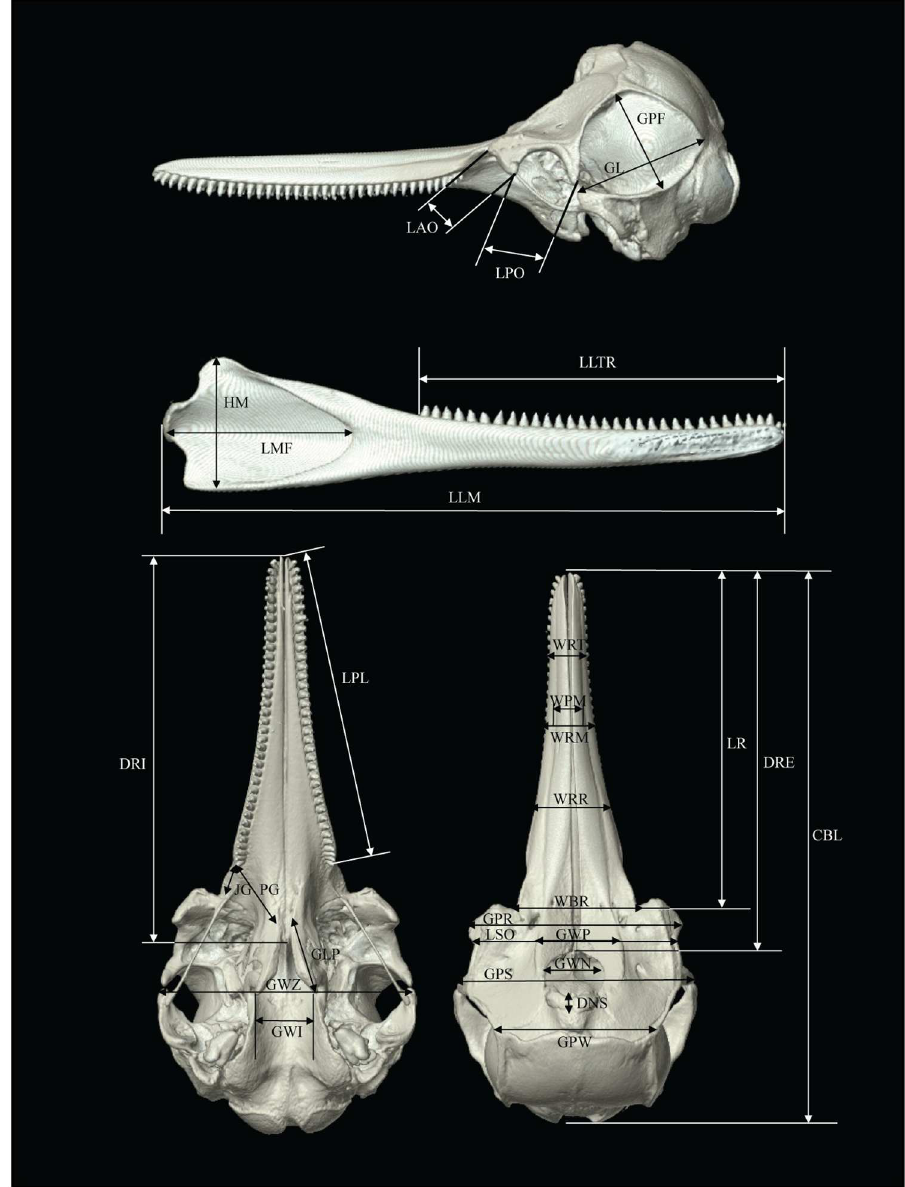
Fig 2. Key to cranial measurements made on CT 3DVRI of Sousa chinensis . For abbreviations, refer to Table 1.